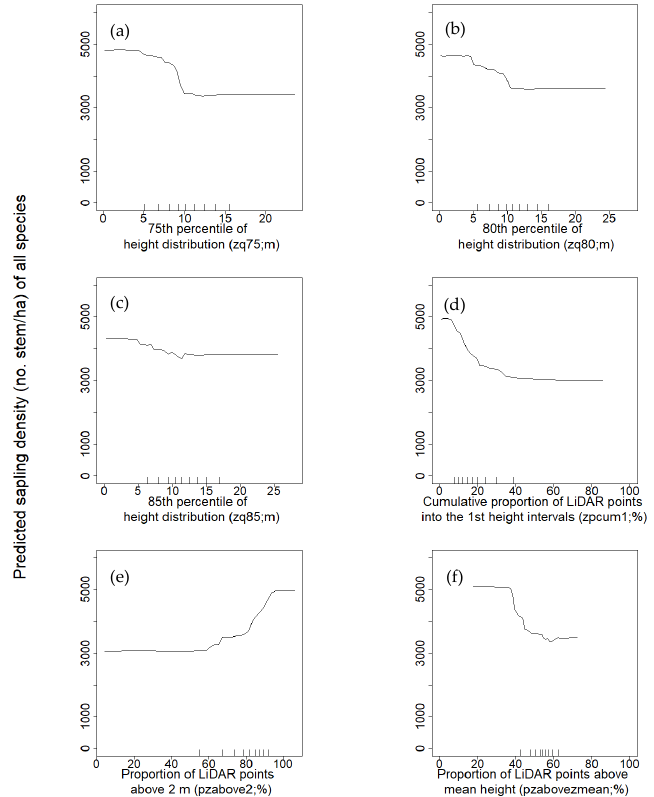
Figure 2. Partial dependence plots of ( a ) 75th (zq75), ( b ) 80th (zq80), and ( c ) 85th (zq85) percentiles of height distribution, ( d ) proportion of points in the first interval from ground (zpcum1), ( e ) proportion of LiDAR points above 2 m (pzabove2), and ( f ) proportion of LiDAR points above mean height (pzabovezmean; %) of random forest predictions of sapling density of all species (stems/ha) using both sensors.